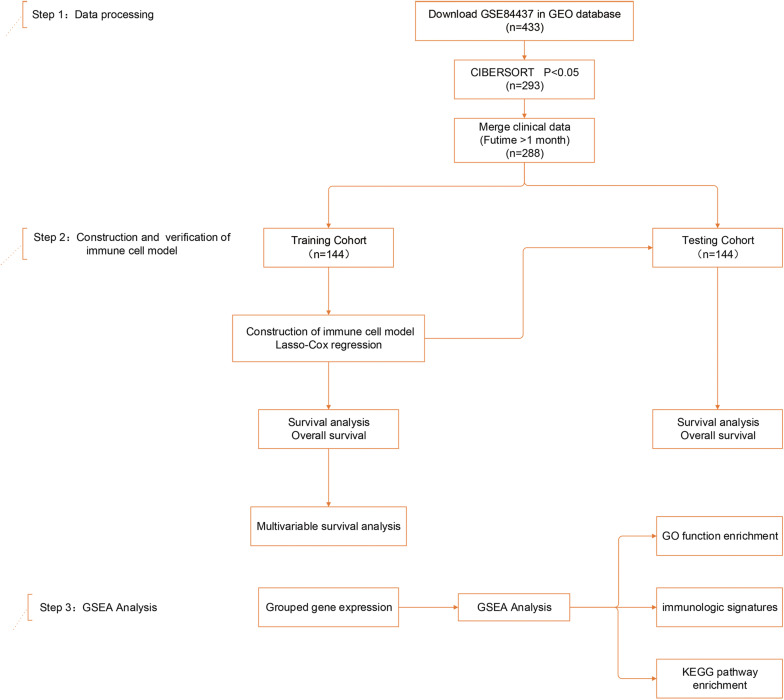
Study design and patient demographics. Step 1: The dataset of study GSE84437, containing 433 gastric cancer tissue samples, was mined using CIBERSORT. Data were filtered based on p-values and clinical outcomes, yielding a final cohort of 288 patients. Patients were divided into training and testing cohorts according to 1:1 ratio using a randomization method. Step 2: Four infiltrating immune cell types in the training cohort were screened by least absolute shrinkage and selection operator (LASSO) and multivariate Cox regression, and validated in both the training and testing cohorts. Step 3: Gene set enrichment analysis (GSEA) analysis was used to identify subgroup differences in gene enrichment.